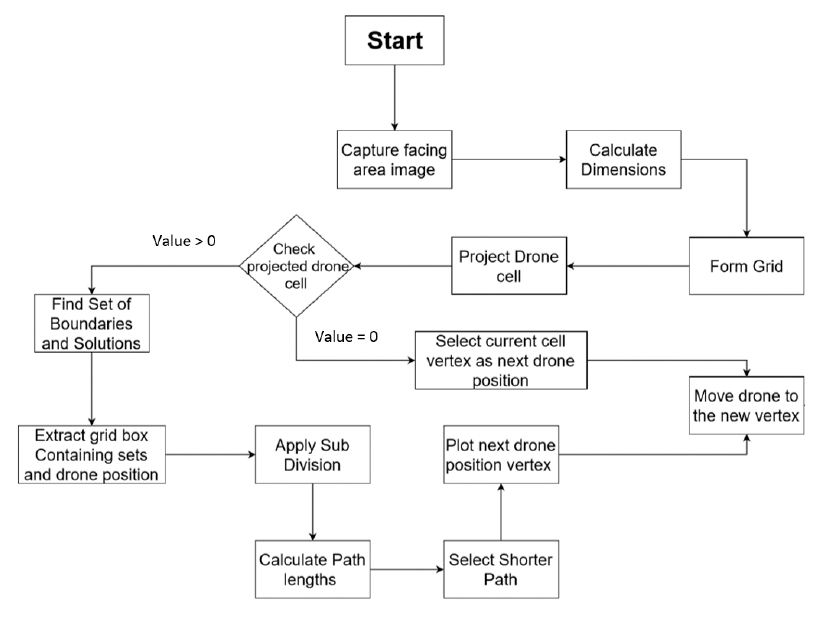
Figure 8. Flow chart of the obstacle detection and avoidance.